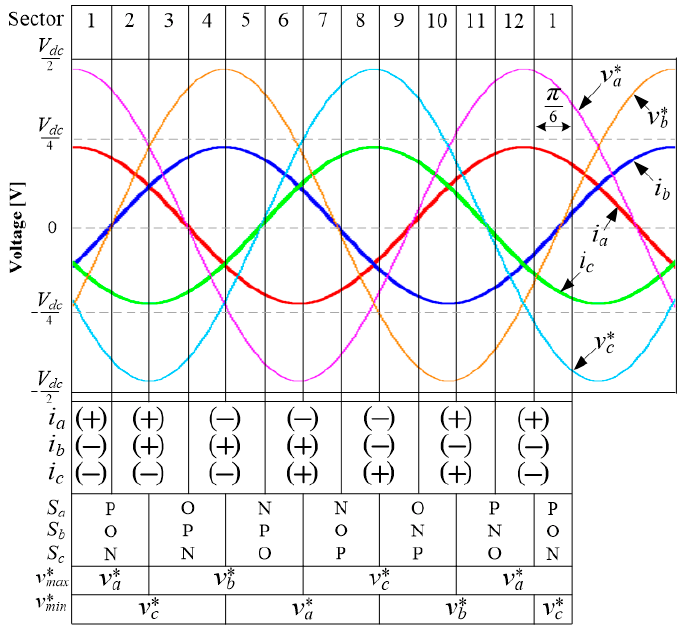
Figure 2. Sectors, input current polarity, switching states, maximum and minimum reference voltages of the rectifier with unity power factor.